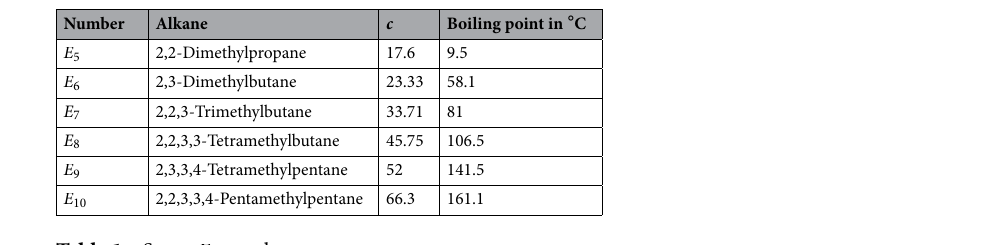
Table 1. Some E n graphs.